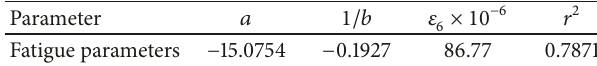
Table 2: Values of fatigue parameters for mix AC 11